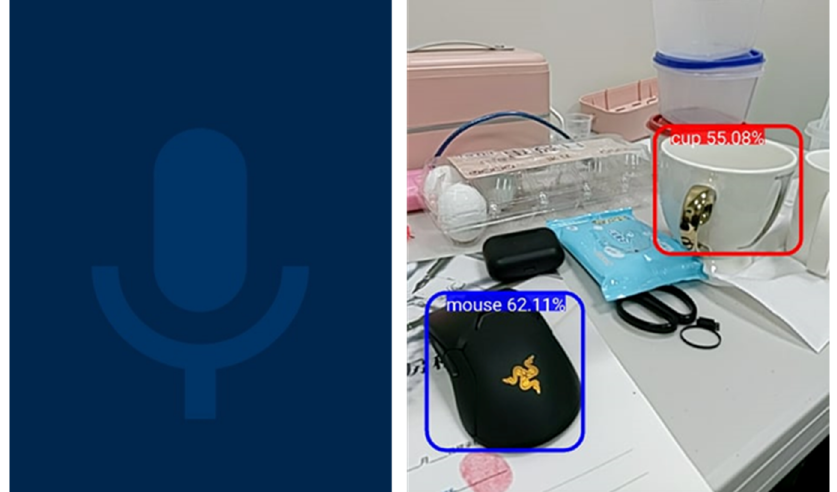
Figure 6. Object detection module with the voice command interface ( left ) and sample object detection result ( right ).